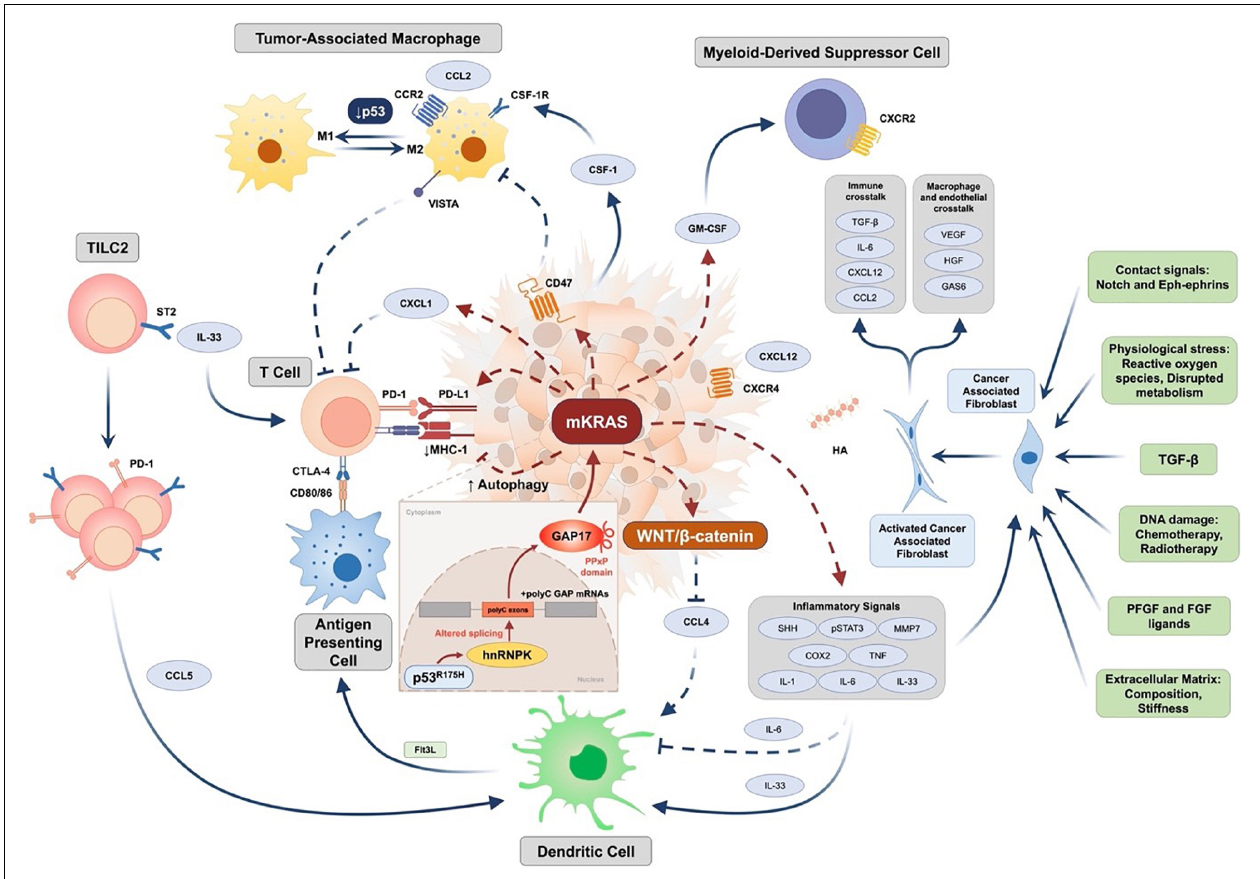
FIGURE 1 | Epithelial and stromal cell interactions in pancreatic cancer (Jones et al., 2008; Waddell et al., 2015; Bailey et al., 2016; Bear et al., 2020; Dominguez et al., 2020; Escobar-Hoyos et al., 2020; Sahai et al., 2020). PDAC immune resistance is driven by complex genetic background. Expression of tumor-intrinsic GM-CSF and CXCL1 is increased by oncogenic KRAS to mediate T cell exclusion and MDSC infiltration. Downstream signaling initiated by mutant KRAS (mKRAS) mediates innate and adaptive immune escape through enhancing autophagy to downregulate MHC-1 expression and upregulate the expression of PD-L1 and CD47. In addition to increased IL-6-mediated systemic dysregulation of conventional type 1 dendritic cell (DC), activation of WNT/ β -catenin mediated by mKRAS signaling further downregulates CCL4 expression to inhibit DC recruitment. Tumor group 2 innate lymphoid cells (TILC2s) infiltrate the tumor microenvironment and are activated by IL-33 through binding to the ST2 receptor, further leading to an enhancement of anti-tumor immunity by expressing the inhibitory checkpoint receptor PD-1 and recruiting DCs potentially through CCL5 production. Furthermore, mKRAS signaling enhances chronic inflammation signaling such as Sonic Hedgehog, COX2, and pSTAT3 signaling, and promotes multiple inflammation-associated factors such as IL-1, IL-6, tumor necrosis factor (TNF), and matrix metalloproteinase 7 (MMP) to activate cancer-associated fibroblasts (CAF). Additional factors leading to activation of CAFs include TGF- β , extracellular matrix (ECM) stiffness and composition, RTK ligands such as PDGF and FGF, DNA damage caused by chemotherapy and radiotherapy, physiological stress, and contact signals such as Notch and Eph-ephrins. Activated CAFs further regulate macrophage and endothelial functions by factors such as VEGF, HGF, and GAS6 and participate in immune crosstalk through TGF- β activation, IL-6, CXCL12, and CCL2 production. Deficiency of p53 mediates transition of TAM toward an immunosuppressive M2 phenotype. Mutant p53 (such as R175H) increases expression of the splicing regulator hnRNPK to promote inclusion of cytosine-rich exons (+polyC exons) within GTPase-activating proteins (GAPs), particularly GAP17, leading to enhanced KRAS activity. CCL2/4/5, CC-chemokine ligand 2/4/5; CCR, CC-chemokine receptor; COX2, cyclooxygenase 2; CSF-1, colony-stimulating factor 1; CSF-1R, colony stimulating factor 1 receptor; CTLA-4, cytotoxic T-lymphocyte-associated protein 4; CXCL1/12, CXC-chemokine ligand 1/12; CXCR4, CXC-chemokine receptor type 4; DC, conventional type 1 dendritic cell; FGF, fibroblast growth factor; Flt3L, Fms related receptor tyrosine kinase 3 ligand; GAS6, growth arrest-specific protein 6; GM-CSF, granulocyte-macrophage colony-stimulating factor; hnRNPK, heterogeneous nuclear ribonucleoprotein K; HA, hyaluronic acid; HGF, hepatocyte growth factor; IL-1/-6/-33, interleukin-1/-6/-33; MHC-1, major histocompatibility complex 1; PDGF, platelet-derived growth factor; PD-1, programmed cell death protein 1; PD-L1, programmed death-ligand 1; SHH, sonic hedgehog; ST2, suppression of tumorigenicity 2; STAT3, signal transducer and activator of transcription 3; TAM, tumor-associated macrophage; TGF- β , transforming growth factor- β ; VEGF, vascular endothelial growth factor; VISTA, V-domain Ig suppressor of T cell activation.